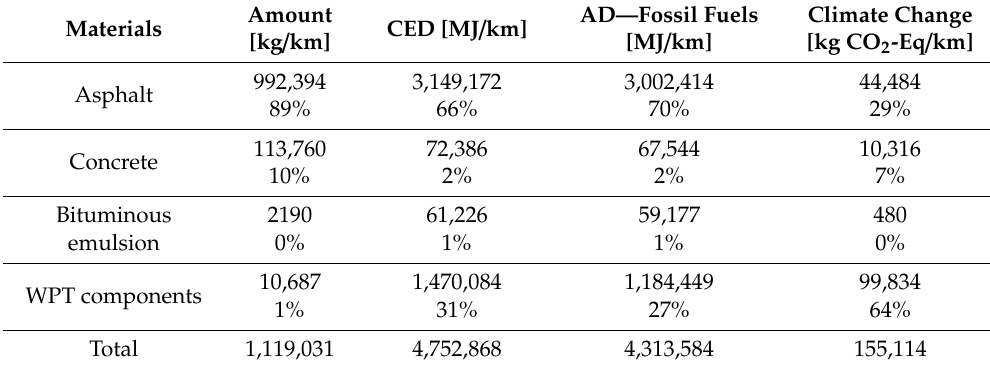
Figure 6. The e-road materials and components: Impacts and weights per km.